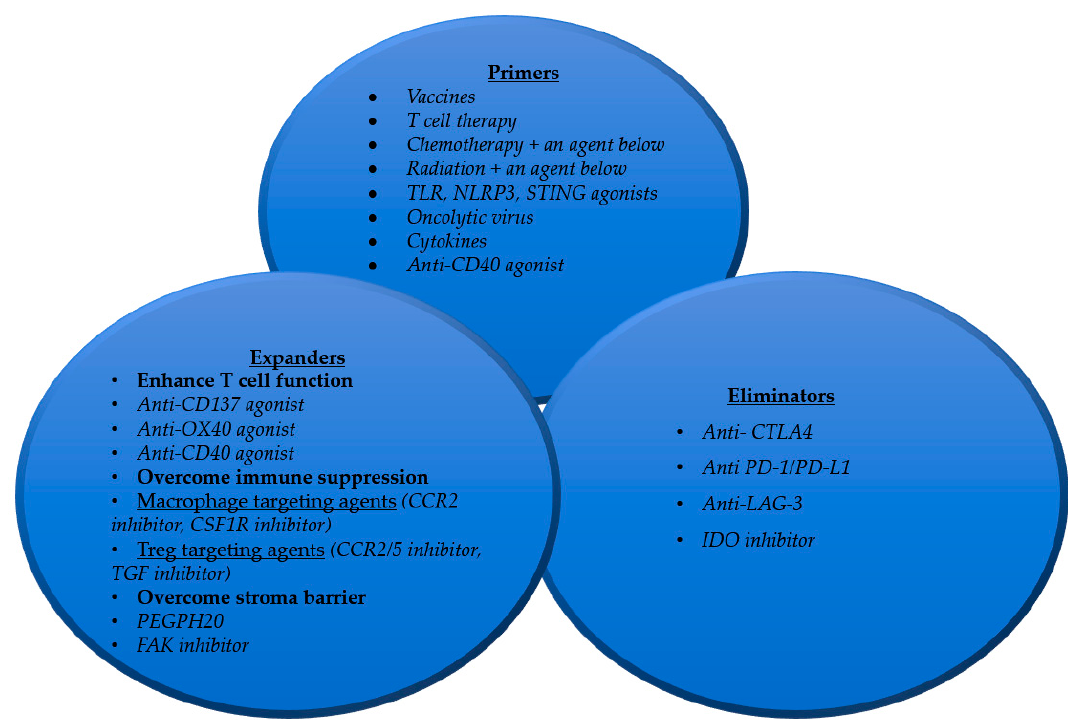
Figure 2. Strategies for developing combination immunotherapy to correct the immune “defects” in pancreatic cancer.